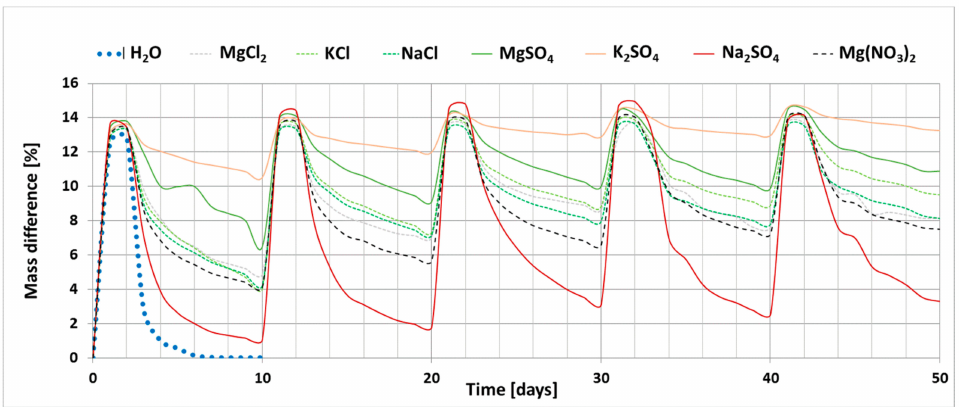
Figure 2. Change in the weight of samples saturated with salt solutions as a function of time (5